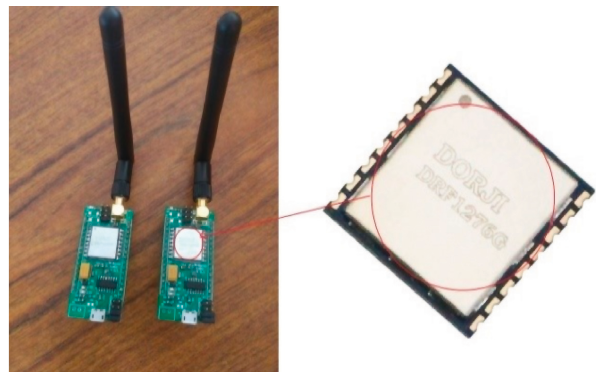
Figure 2: Arduino DRF1276G with LoRa module used for implementing cryptographic